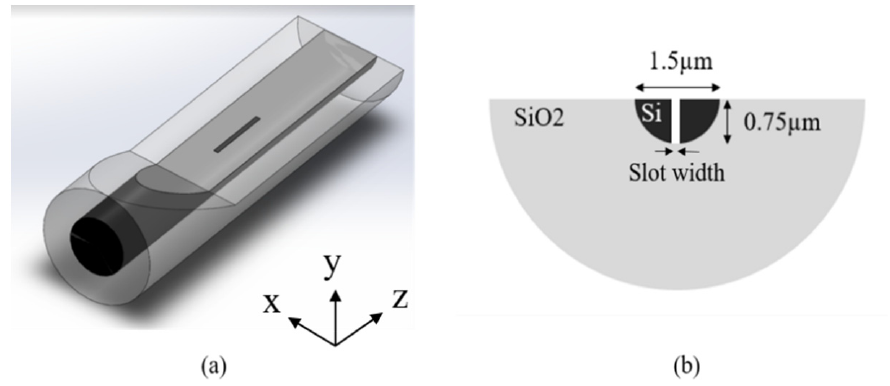
Figure 4. ( a ) The simulation model of an SW in DSCF. ( b ) The cross section of the slot region.